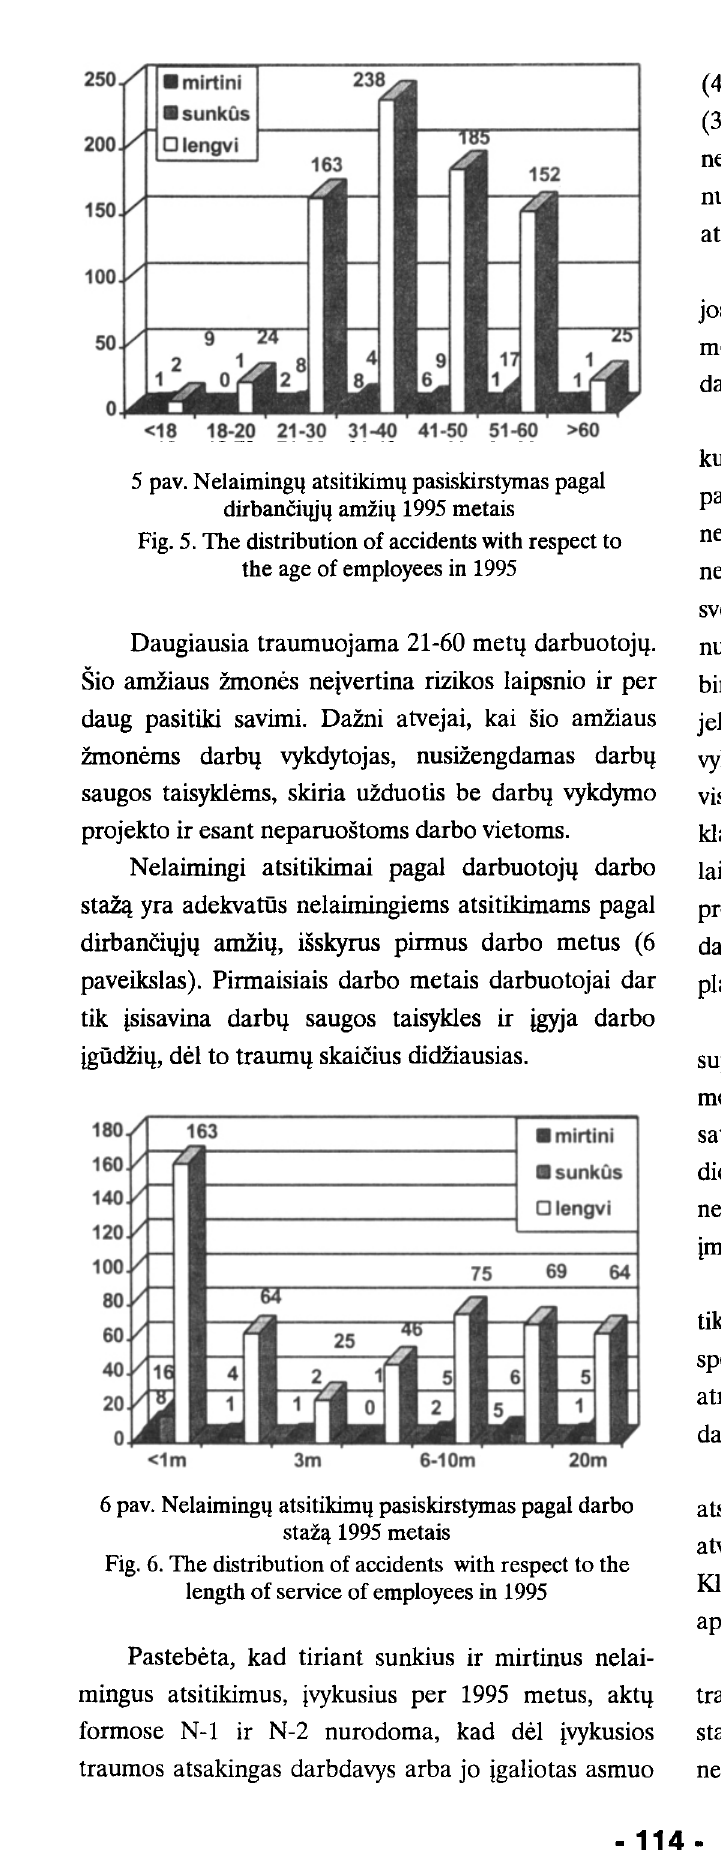
Fig. 6. The distribution of accidents with respect to the length of service of employees in